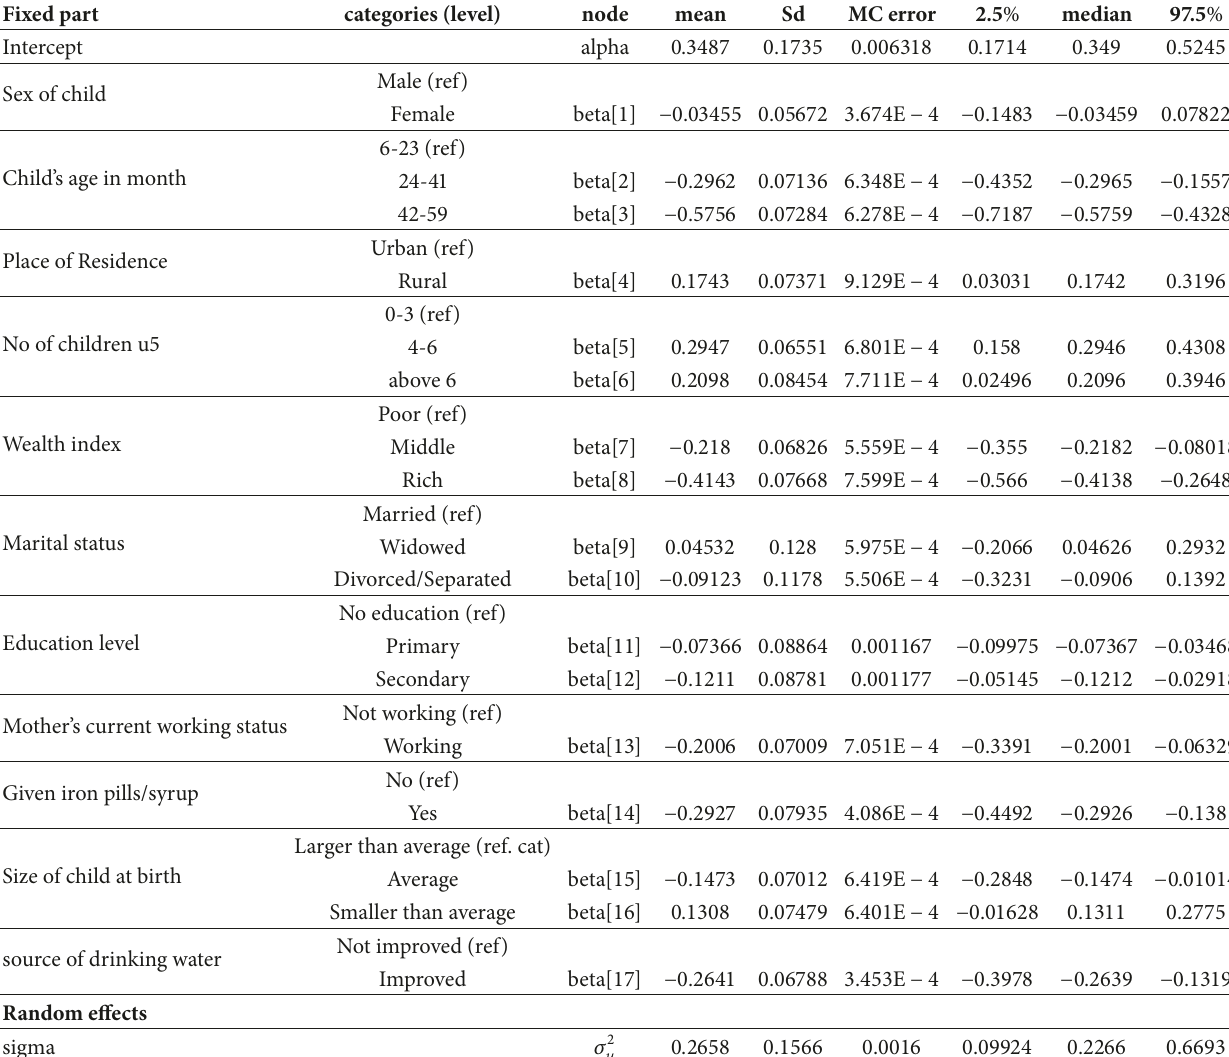
Table 6: Bayesian estimates for random intercept